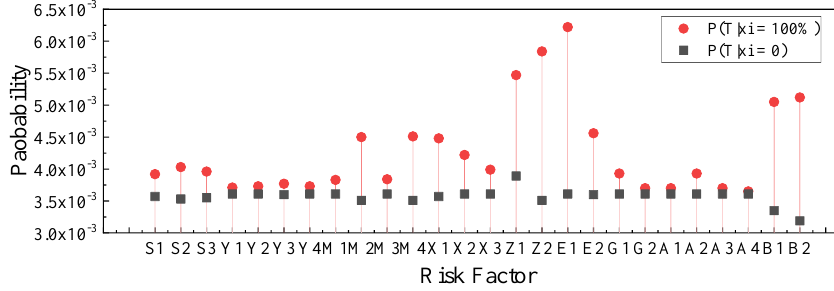
Figure 9. Risk factor sensitivity analysis for disconnect failure.